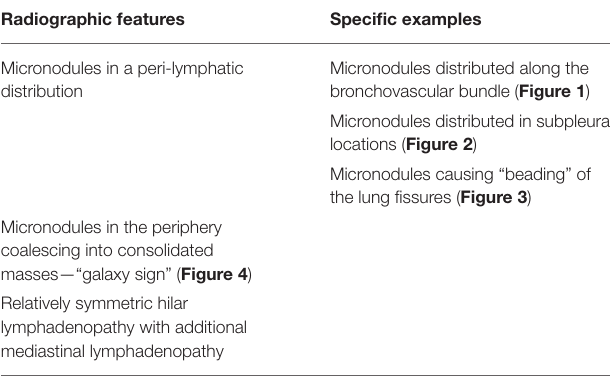
TABLE 3 | Typical radiographic findings of pulmonary